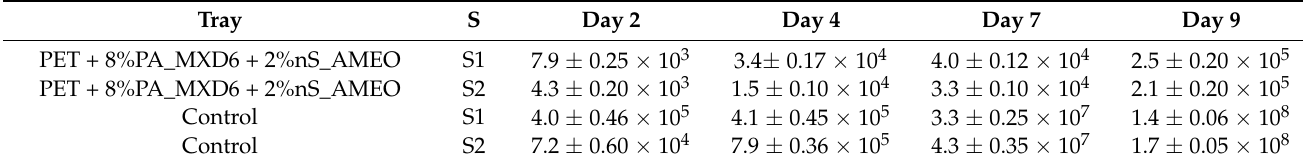
Table 7. Mesophilic aerobes count (ufc/g) in sliced sea bam packed in MAP.